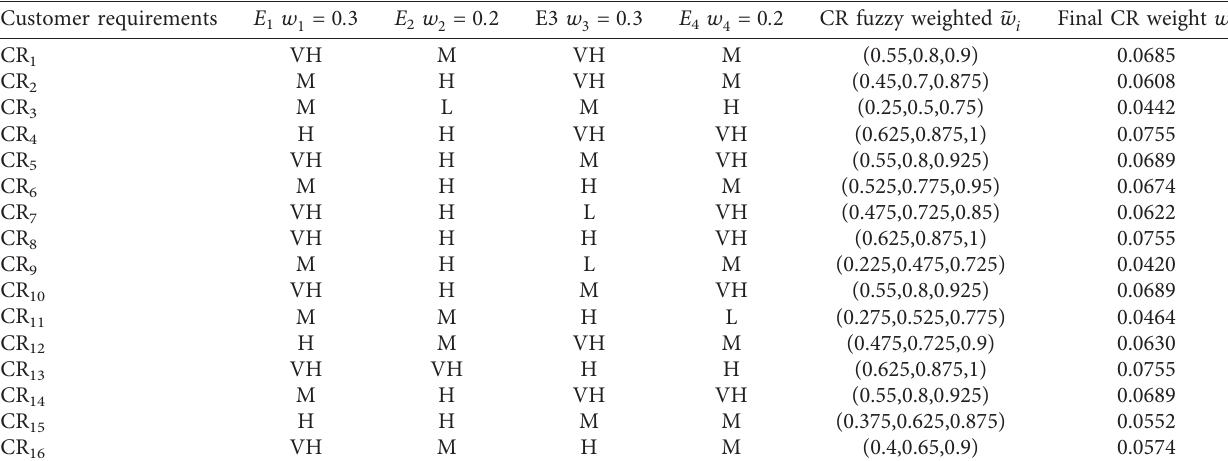
Table 5: CR importance evaluation information and its weight. Customer